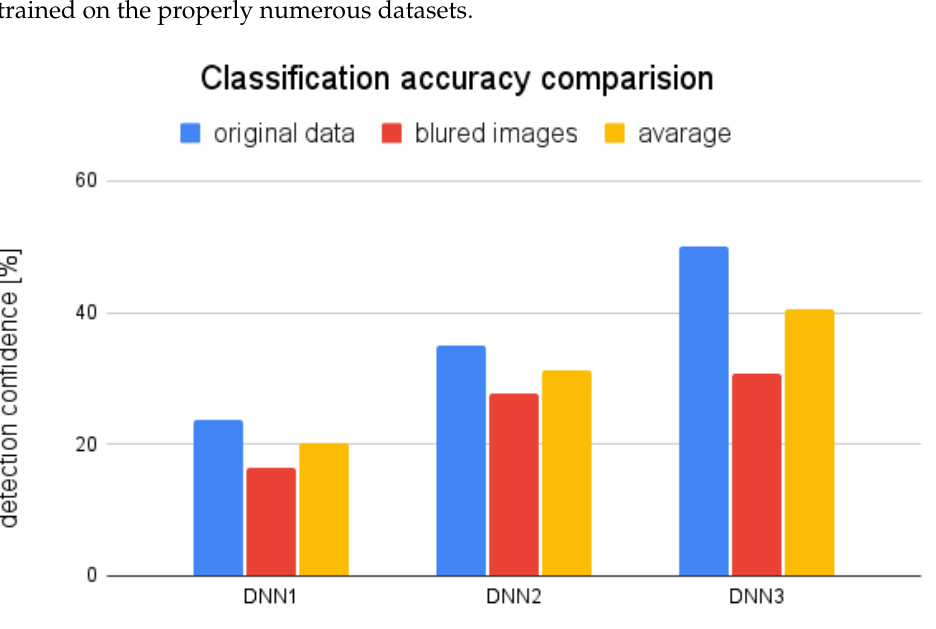
Figure 8. Average confidence returned by models trained on the different